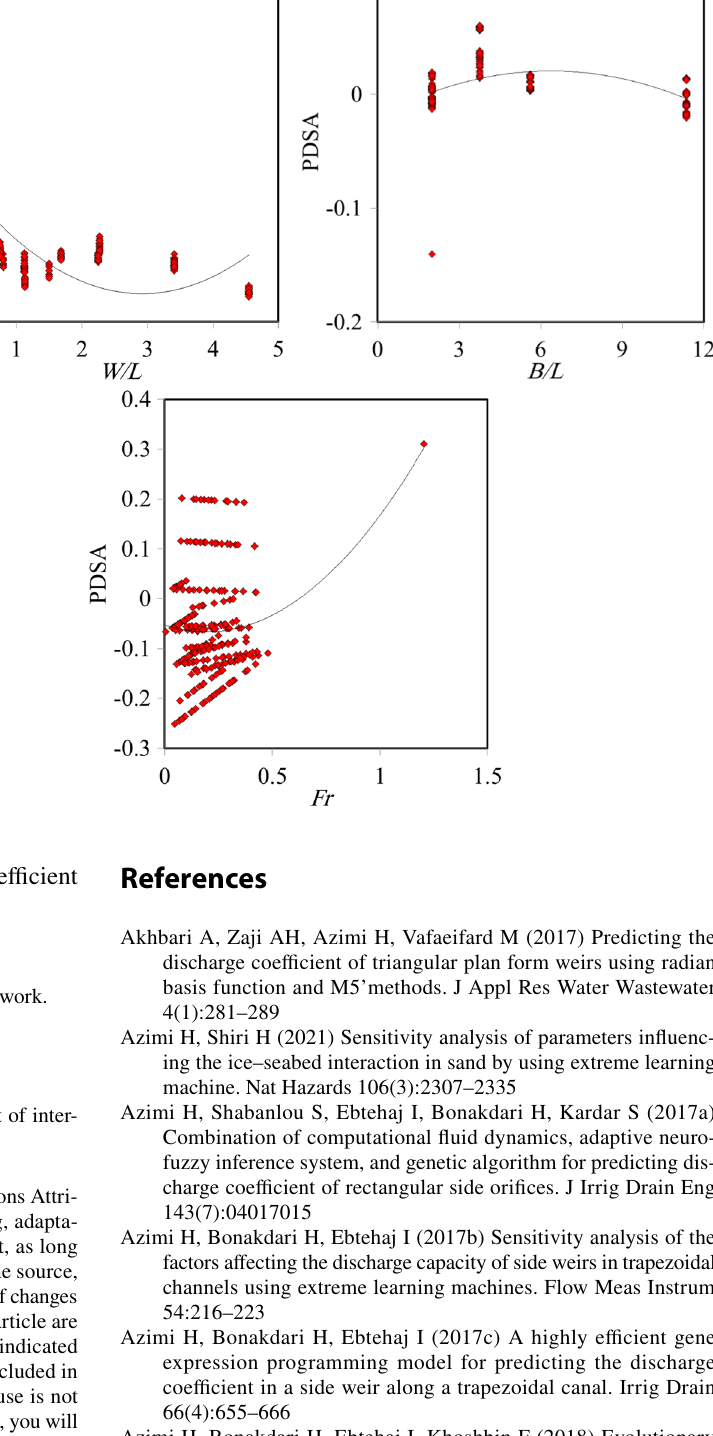
Fig. 13 Results of PSDA for superior model